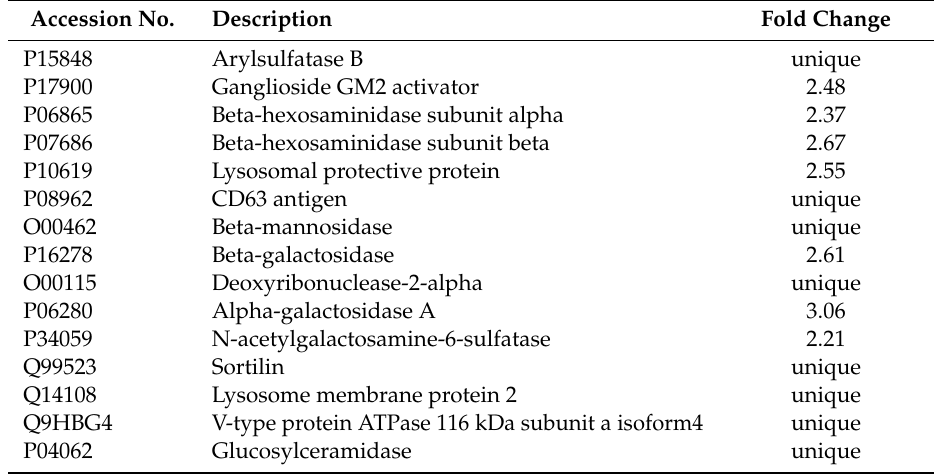
Table 2. The identified proteins which related to the lysosome pathway at more than 2 times fold